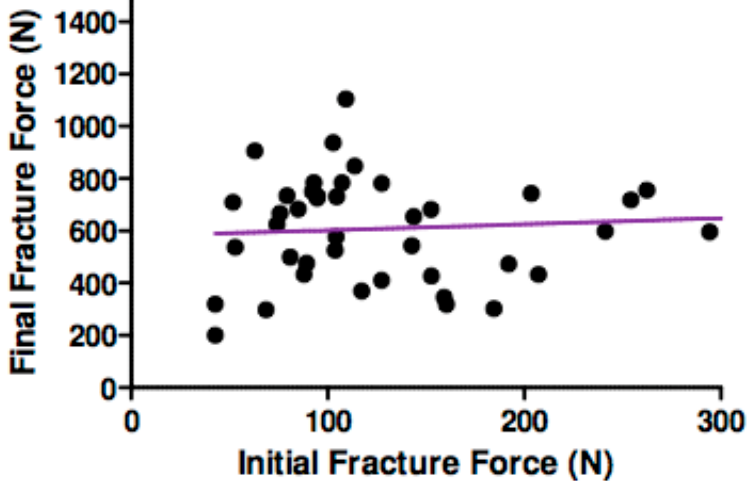
Figure 5. Graph correlation of initial and final fracture force (N).